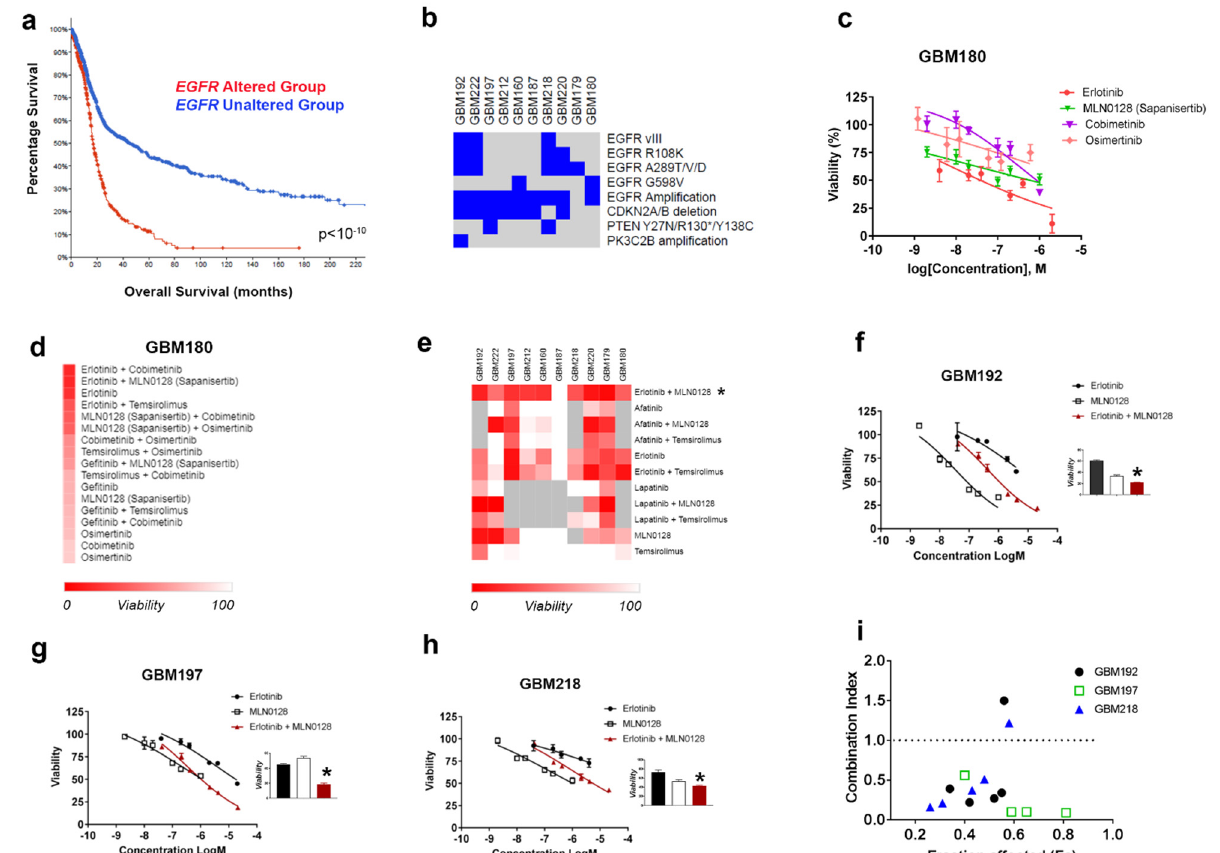
Figure 1. Response of EGFR-driven GBMs to combinatorial targeted therapy. ( a ) Kaplan–Meier survival curves in GBM patients with (red line) or without (blue) EGFR alterations (TCGA database). ( b ) Summary of genomic alteration in the subset of GBM samples used for functional studies in this manuscript; blue squares indicate the presence of the alterations listed on the right side of the dia- gram. ( c ) Full-dose response in GBM 180 treated with 4 targeted therapies, as indicated. ( d ) Heatmap representing the ranking of anti-tumor efficacy for all drugs and combinations used against GBM180. ( e ) Heatmap representing response to drug combinations across the ten GBM samples listed on top of the heatmap (red denotes maximum response; grey not tested). ( f – h ) Complete dose-response curves, representing cell viability changes in the presence of erlotinib, MLN0128, and the combination of the two drugs in GBM192 ( f ), GBM197 ( g ), and GBM218 ( h ). Inset graphs show anti-tumor efficacy at 10% Cmax. * p < 0.05 two-way ANOVA. ( i ) Combination index values across 6 concentrations for erlotinib+MLN0128 in 3 distinct samples (GBM192, GBM197, GBM218) are shown. The frac- tion affected represents the percentage of cells killed by each of the drug combinations evaluated. Calculations were performed using Compusyn software. All values below 1 represent synergistic interactions between the